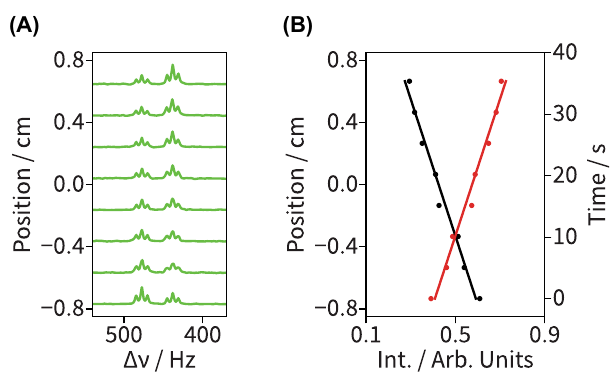
Fig. 3 1D Slice-selective NMR spectra of the enzymatically-catalyzed hydrolysis reaction described in Fig. 2. A Slice-selective (2 mm) 1 H NMR spectra of the methyl region acquired at 8 distinct positions along the NMR coil, collected under similar experimental conditions as those in Fig. 2, but utilizing a 1 second acquisition time. The improved resolution reveals the J - coupling of the sites. B Integrated signal intensities for the reactant (black circles) and product (red circles) plotted as a function of both position and reaction time against the lines of best fi t from the kinetic analysis ( k cat = 12.0 s − 1 and t 0 = 45